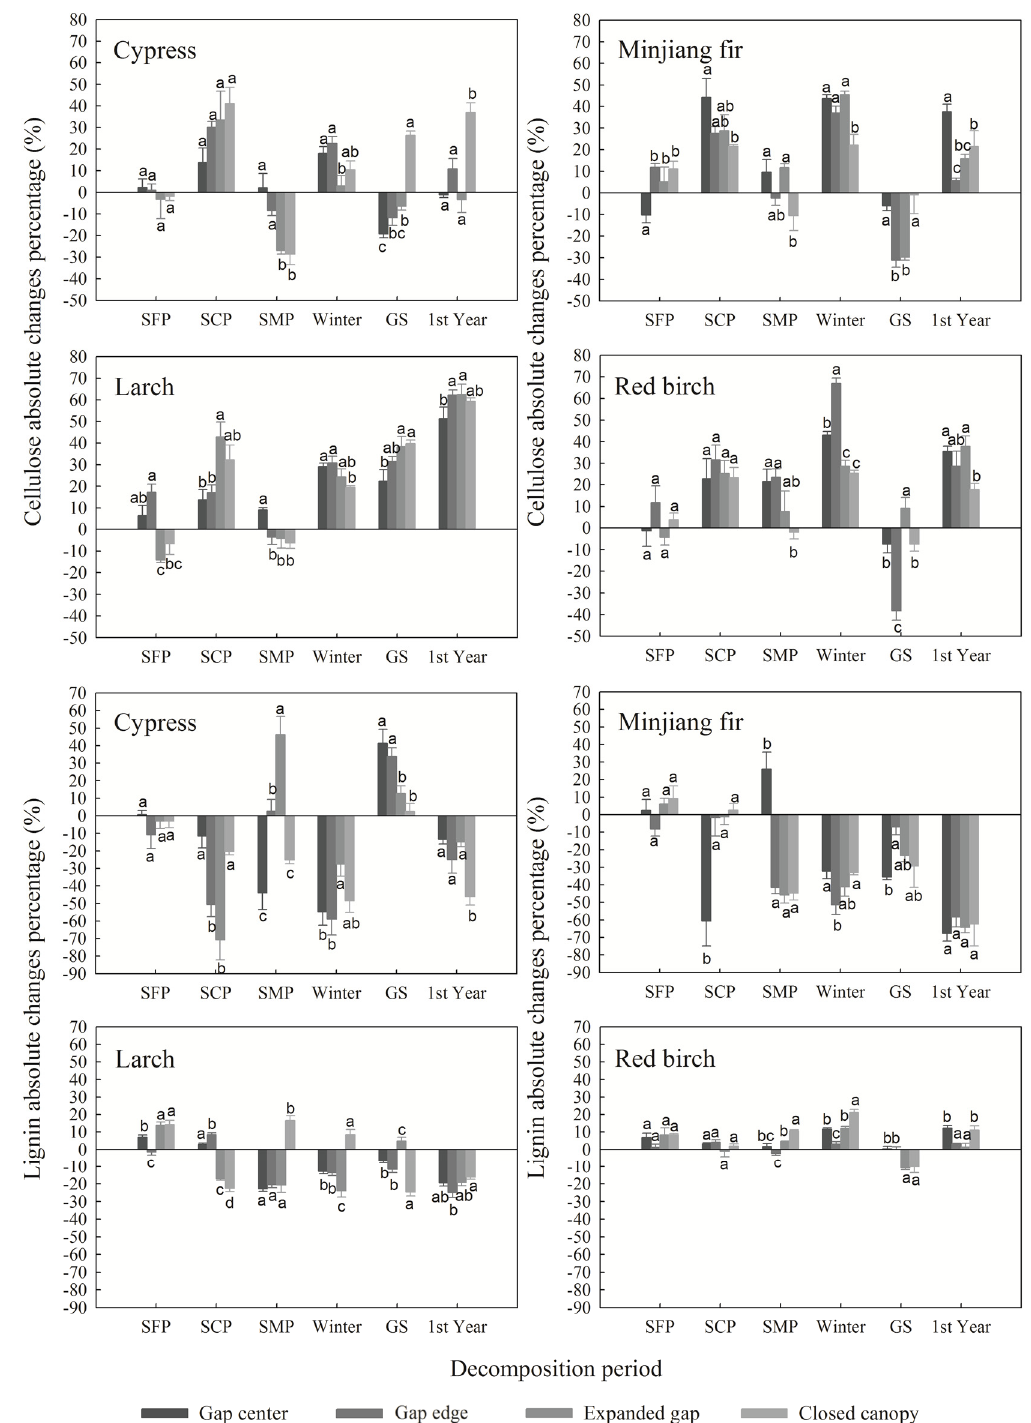
Figure 5. Cellulose and lignin absolute change percentages (%) for the four types of foliar litter (cypress, Minjiang fir, larch, red birch) in the four gap positions (gap center, gap edge, expanded gap, closed canopy) for each decomposition period (SFP, snow formation period; SCP, snow cover period; SMP, snow melt period; Winter, all of winter; GS, growing season; 1st Year, the first year of litter decomposition) over the first year of litter decomposition in an alpine Minjiang fir forest. Different lowercase letters indicate significant differences among gap positions for the same degradation period, p < 0.05 (mean ± SE, n = 3).